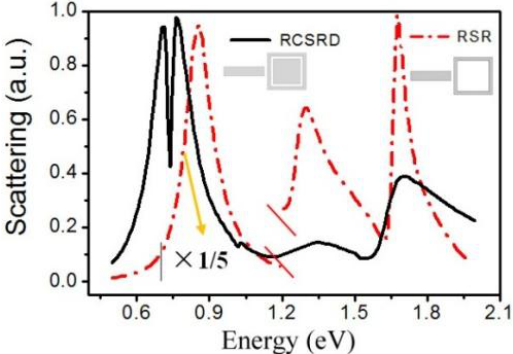
Figure 2. The scattering spectra of RCSRD and RSR with the same parameters of L and g = 20 0